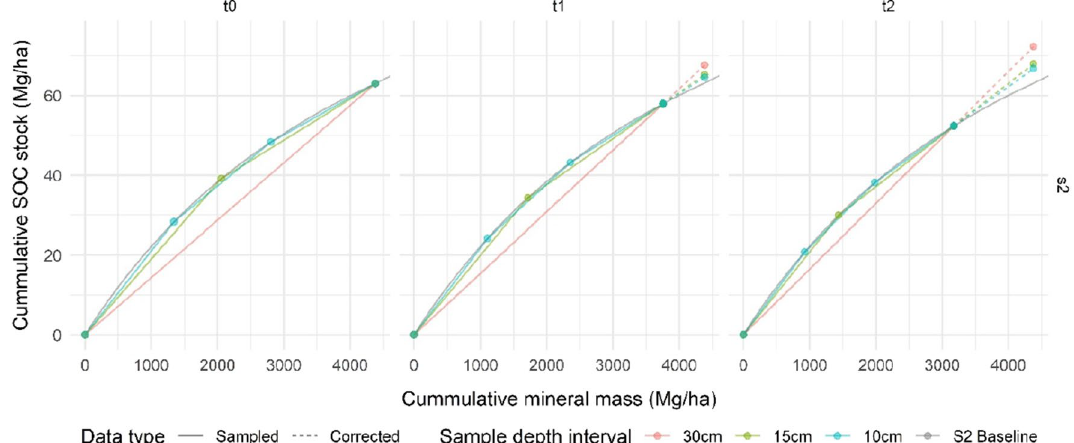
Figure 4. Corrected cumulative SOC stock (Mg ha −1 ) per cumulative mineral mass for scenario 2 at each time point for sample depth intervals 10 cm, 15 cm, and 30 cm (scenarios 2a, 2b, and 2c, respectively) compared to the scenario 2 baseline profile (grey). Sample lines (solid) converge on the 30 cm interval sample depth with the 30 cm sample line (orange) equivalent to scenario 1. Data type is shown by line type where sampled data are solid and corrected data are